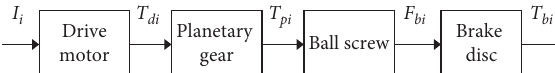
Figure 8: The schematic diagram of the BBW system actuator. I is the drive motor armature current, T di is the motor output torque, T pi is the planetary gear output torque, F bi is the brake pad pressure on the brake disc, and T bi is the brake disc output